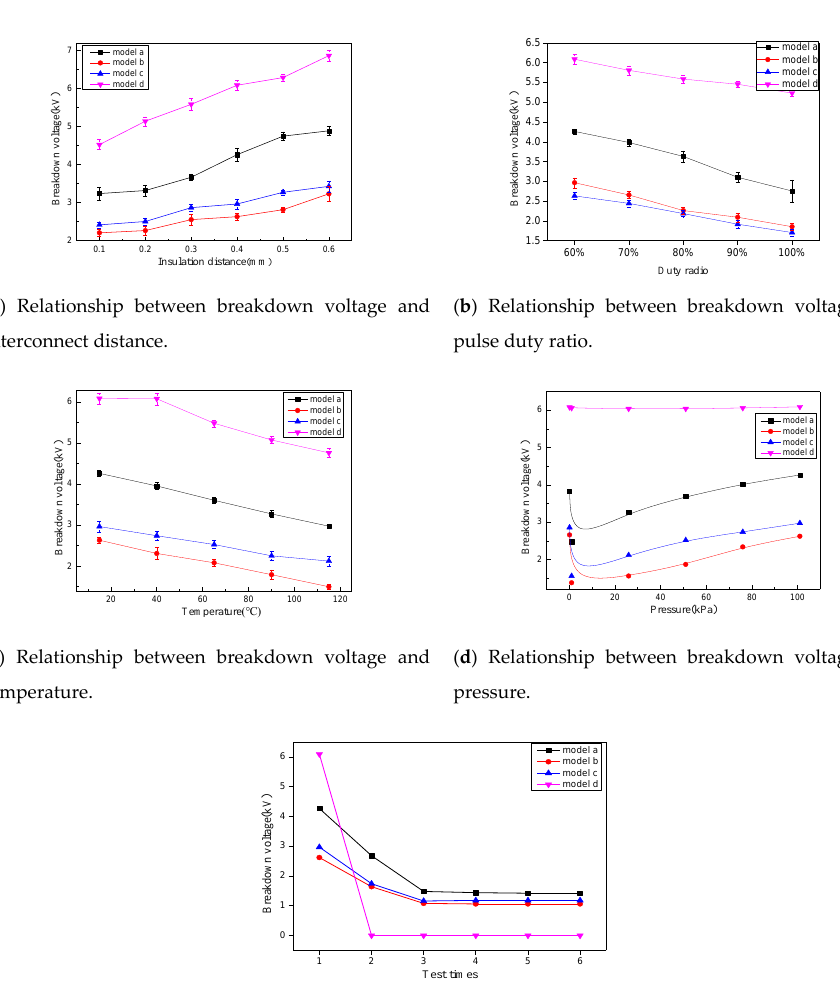
Figure 7. Influence of different factors on the breakdown voltages of the four models.